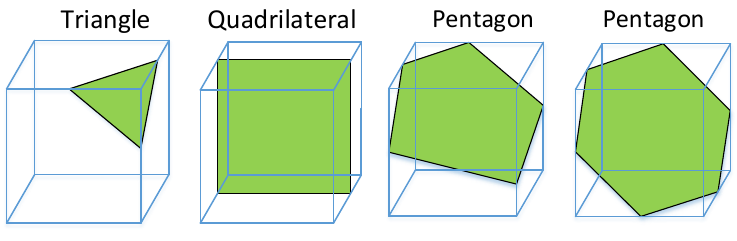
Figure 5. Possible shape after plane cutting